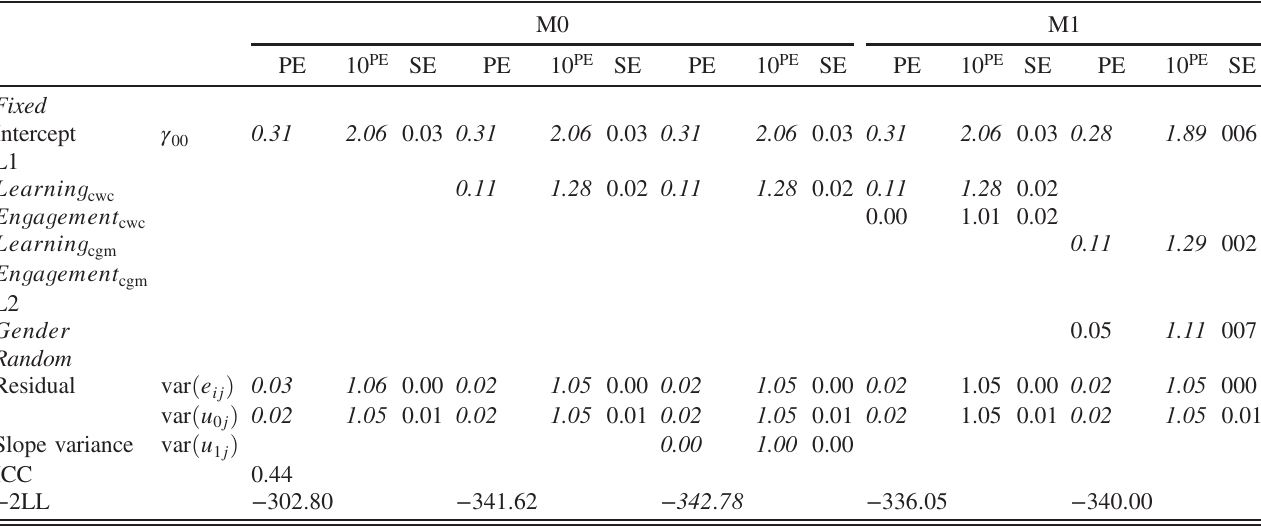
TABLE XI. First half of hierarchical linear modeling results with LOG10(accelerants) as the outcome. All statistically significant parameter estimates (PE and 10 PE ) are in italic font. The − 2 LL was used to compare same models with and without slope variance; italic font indicates better fit.